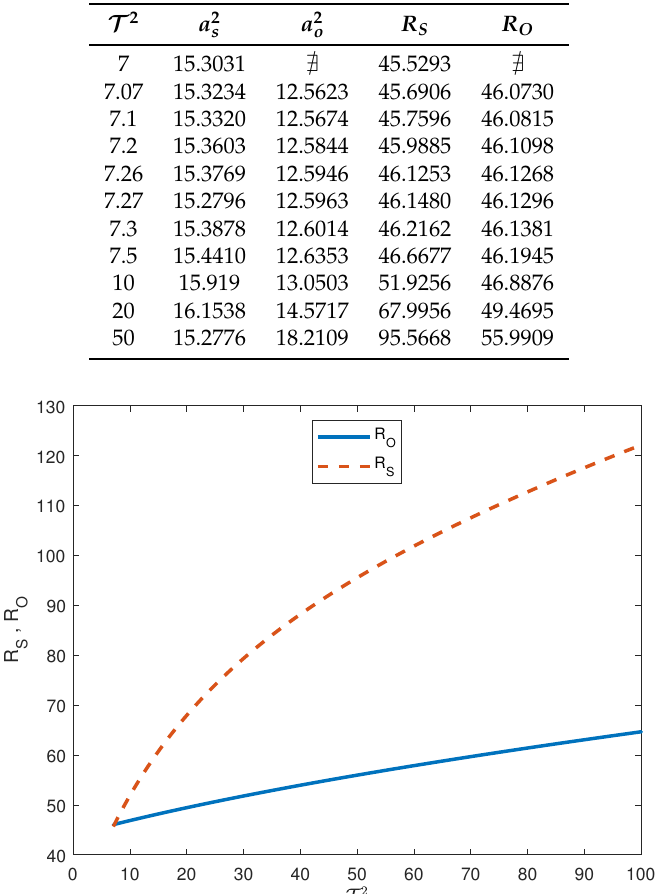
Figure 4. Behaviour of R S and R O with respect to T . The other parameters are set